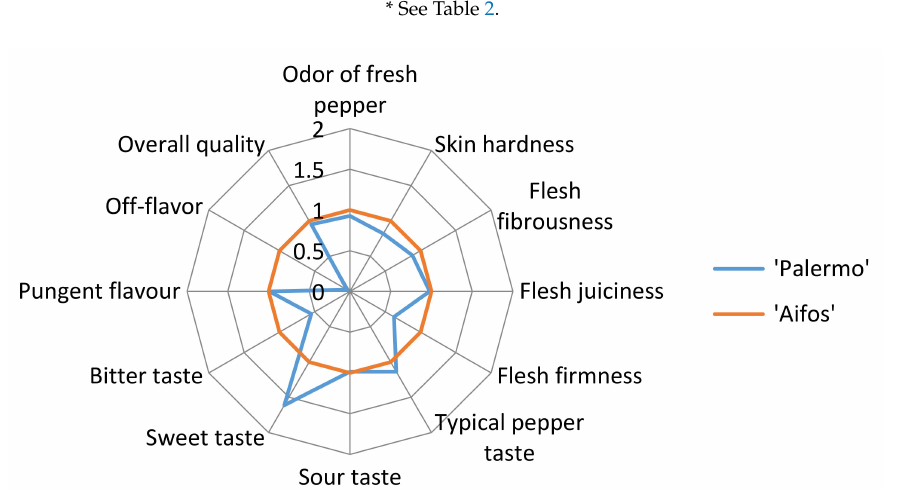
Figure 7. The results of sensory analysis concerning odor, texture and taste and overall quality for pepper fruits normalized to the values of ‘Aifos’ cultivar as radar plots compared to the ‘Palermo’ cultivar (average of two